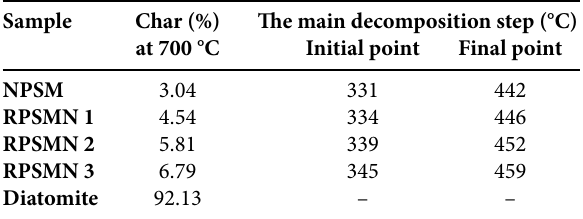
Table 4: Extracted data from TGA curves for the neat copolymer and its nanocomposites Sample Char (%)